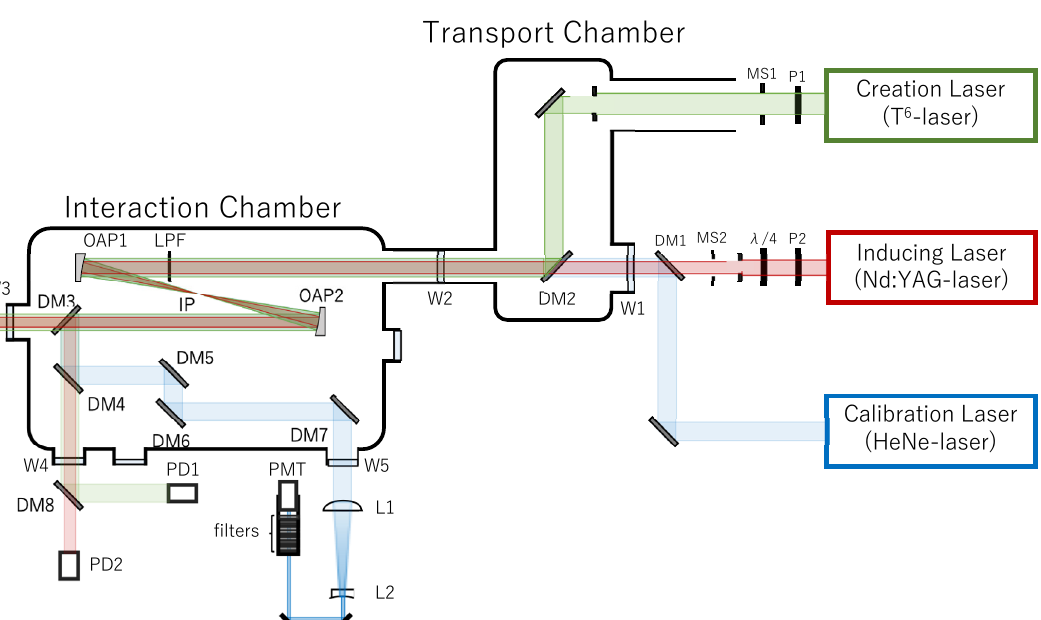
Figure 5 . Schematic of the searching system contained in the beam transport chamber and inter- action chamber designed to achieve 10 − 8